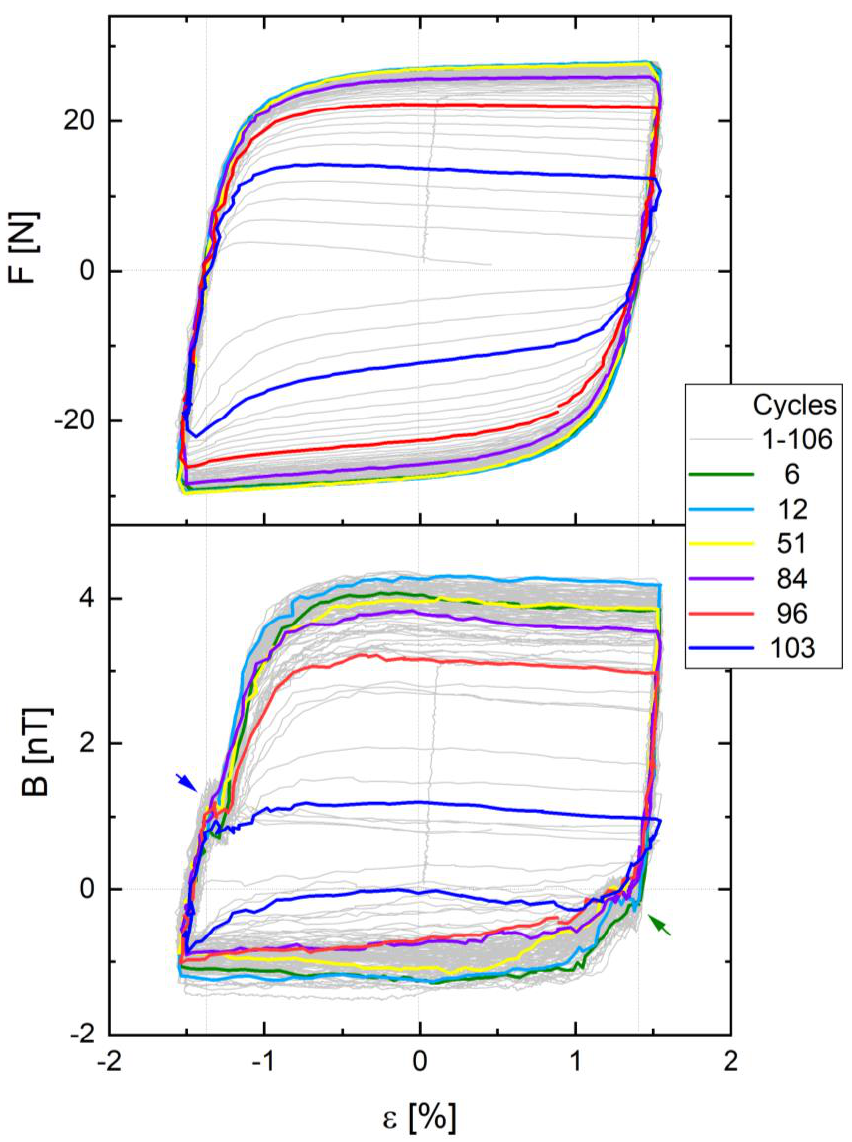
Figure 3. The two observables, mechanical ( F − ε ) and piezomagnetic ( B − ε ) hysteresis curves, for the SUT. Six different cycles are highlighted to show the evolution of the hysteresis with an increasing cycle count. The most pronounced change in the observables is the emergence of “Villari reversals” on the ( B − ε ) hysteresis (marked by arrows). Another prominent difference is the evolution of the surface areas. An inflection of the hysteresis curve is visible between cycles 96 and 103 just before failure of the specimen.